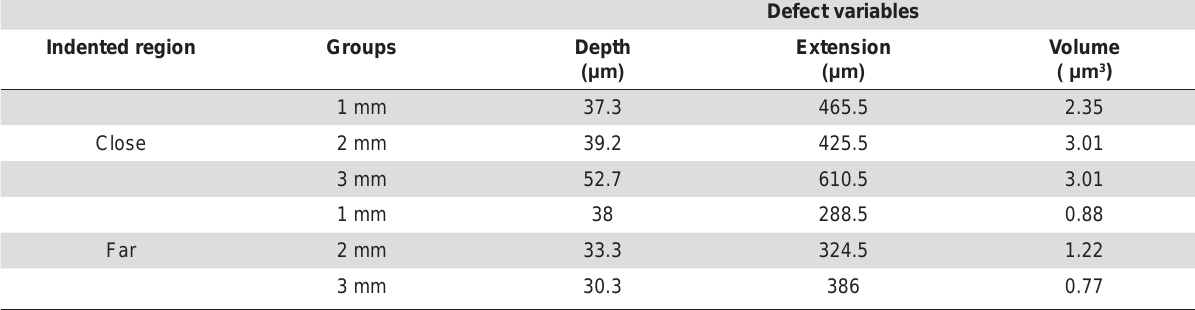
Table 3- Mean value of depth, extension, and volume close to and far from zirconia